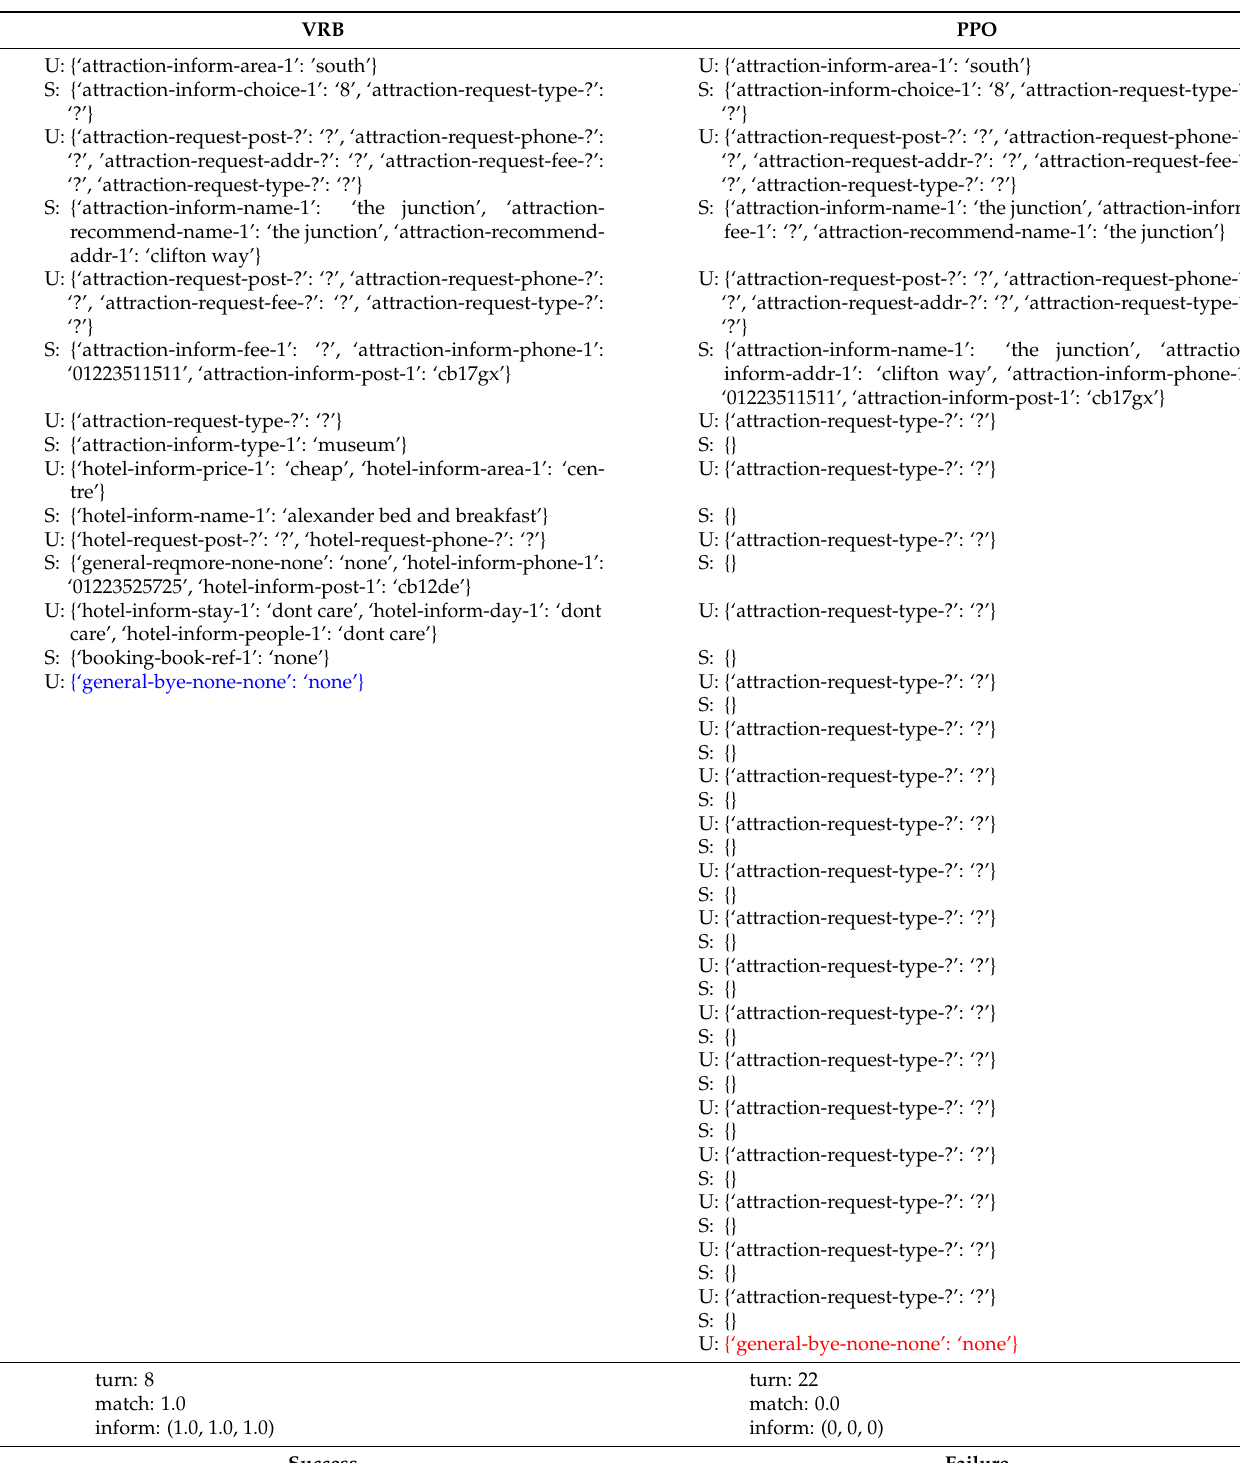
Table 4. A comparison between VRB and PPO with respect to the dialogue act. VRB